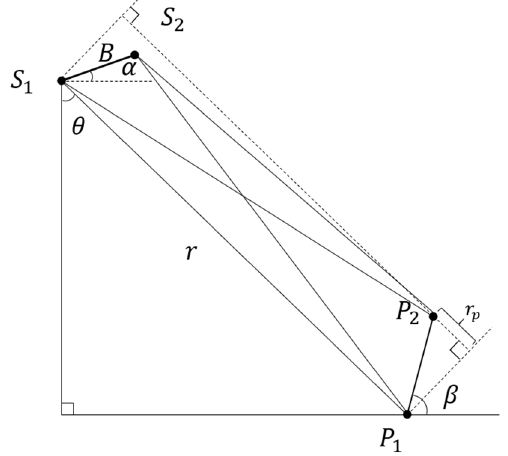
Figure 3. The InSAR geometry model of layover area.